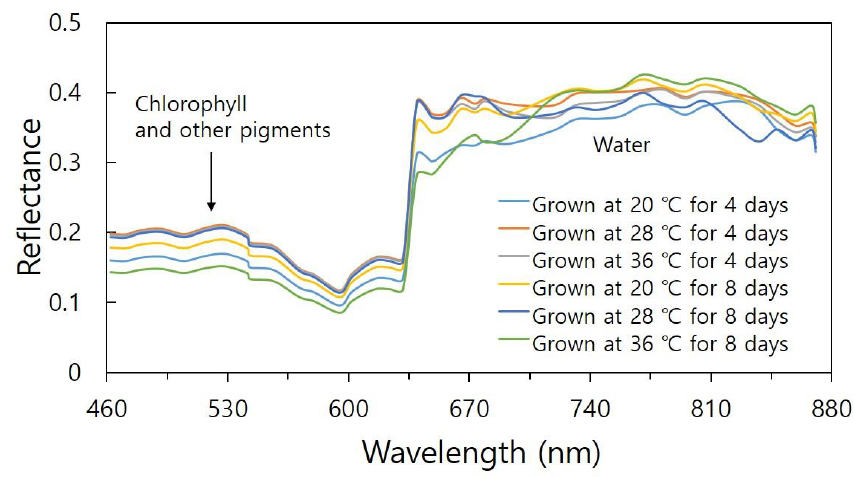
Figure 3. Average reflectance spectra of heat-stressed samples from 460–860 nm; reflectance spectra under different temperatures (20 °C, 28 °C, and 36 °C on days 4 and 8.